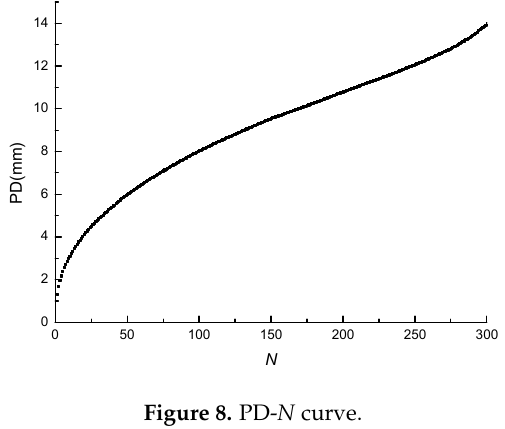
Figure 8. PD- N curve.